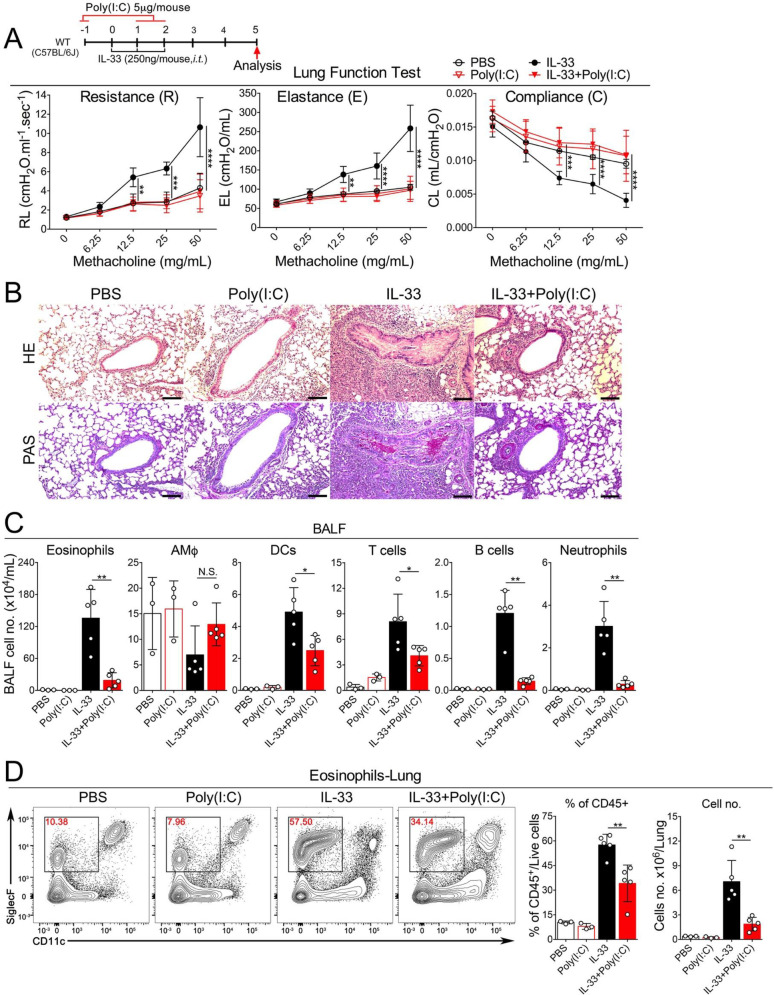
Poly(I:C) at a low dose inhibits IL-33-induced AHR and acute eosinophilia.A. Groups of mice as indicated were treated with PBS, IL-33 with or without Poly(I:C) (5 μg/mouse) as indicated. Lung function was examined by Flexivent (Scireq). Airway resistance (R), elastance (E) and compliance (C) were measured after exposure to increasing doses (6.25–50 mg/mL) of aerosolized methacholine. (n = 3–5, P value <0.05 was considered statistically significant, 2way ANOVA, Tukey’s multiple comparisons test, * p < 0.05, ** p < 0.01, *** p < 0.001, **** p < 0.0001). B. Lung pathology was assessed with H&E and PAS staining. Representative images are shown here (scale bars, 100 μm). C. Bronchoalveolar lavage fluid (BALF) was collected and analyzed for differential immune cell types. The result is a pool of two independent experiments. (n = 3–5 per group as indicated with open circles). D. Administration of Poly(I:C) decreased the percentage and number of eosinophils in lungs after exposure to IL-33. (n = 3–5 per group as indicated with open circles).